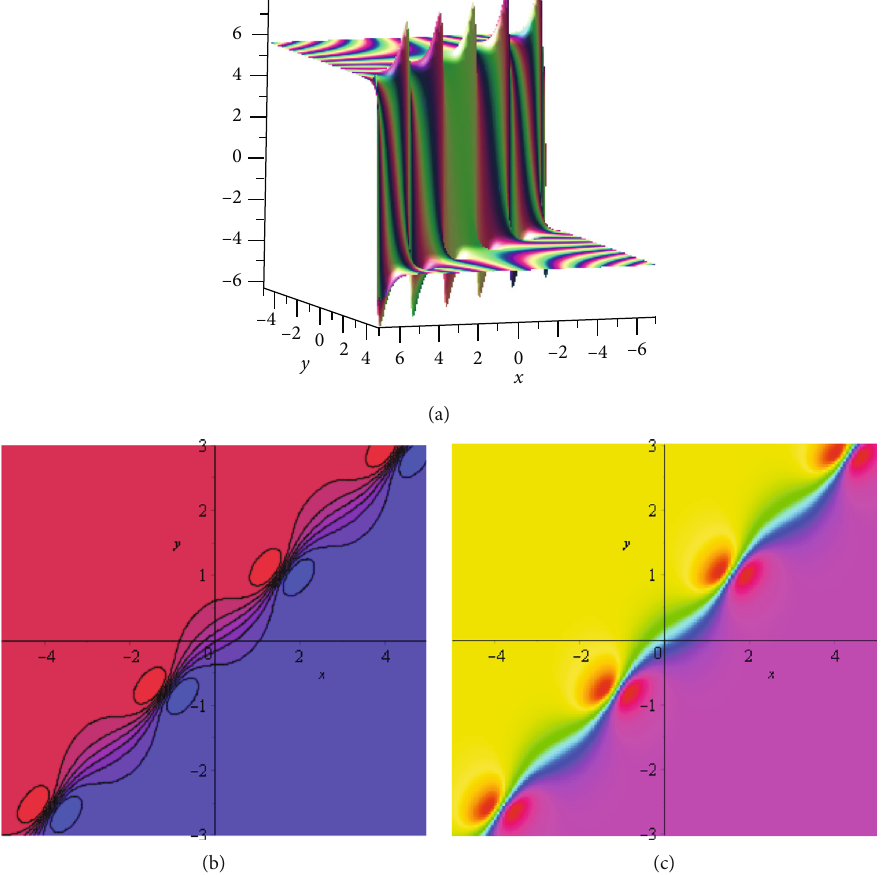
= : 5, a = 1 : 5, a = 2, a = 1, Ω = 1 : 5, Ω = 1 : 2, δ = 1, δ = 1 : 3, δ = 2, δ 1 2 3 4 4 5 1 2 3 4